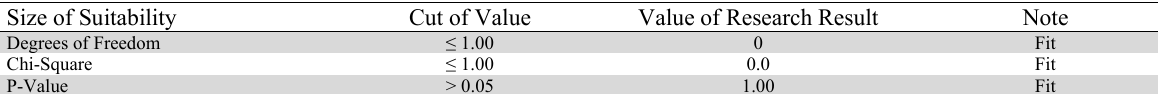
Good of Fit Structural Model